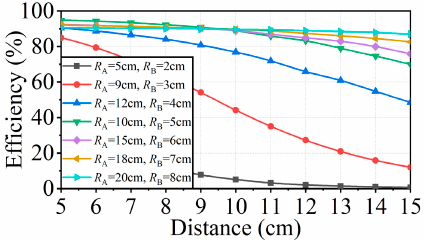
Figure 8. PTE curves with different coil combinations.